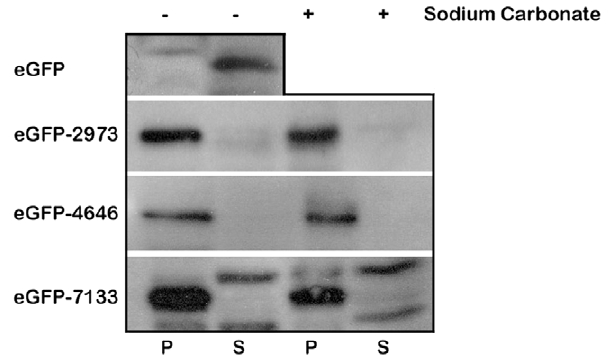
Figure 5. Protease protection assay to assess TAMP orientation at the membrane. Protoplasts expressing ActR, SCO2900, SCO2973, SCO4646 and SCO7133 were subjected to increasing concentration of Proteinase K (PK). Exterior facing N-termini were expected to be susceptible to Proteinase K digestion; while inward facing N-termini were expected to be protected. Visualization of the extent of degradation was detected by Western blot analysis against the FLAG